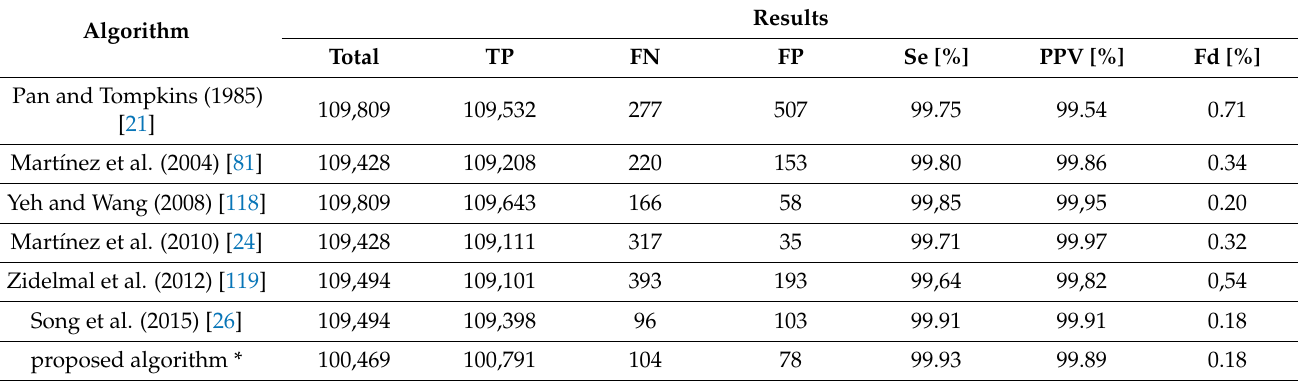
* Results displayed in Table 2 bottom line are here rounded to two decimal points for data